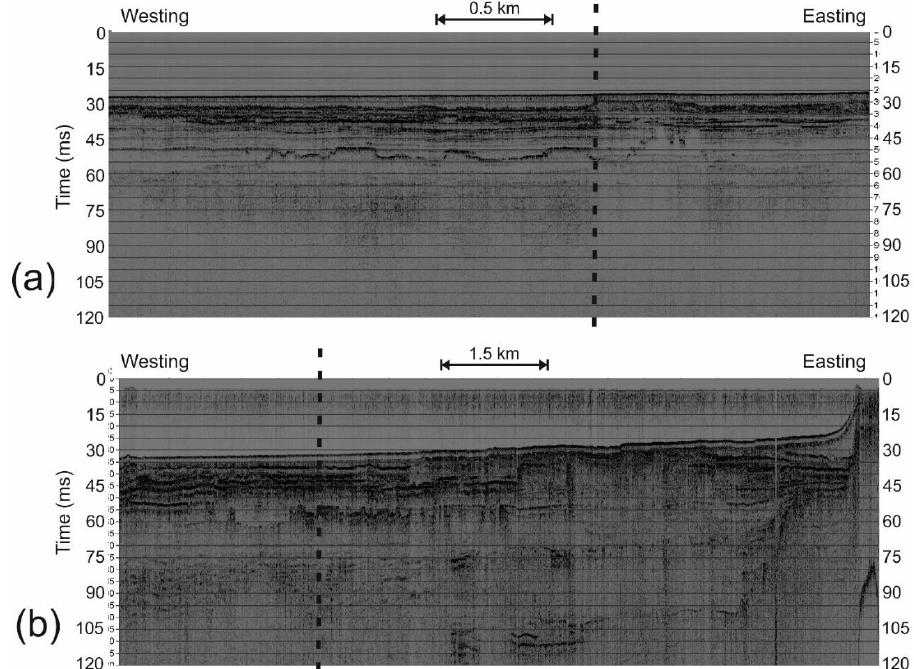
Figure 10. Two intersecting profiles acquired at the Gulf of Trieste (Adriatic Sea) using a Chirp system ( a ) and a Boomer system ( b ).